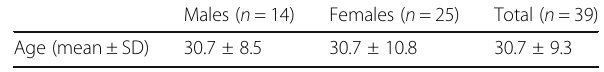
Table 1 Demographic composition of the study